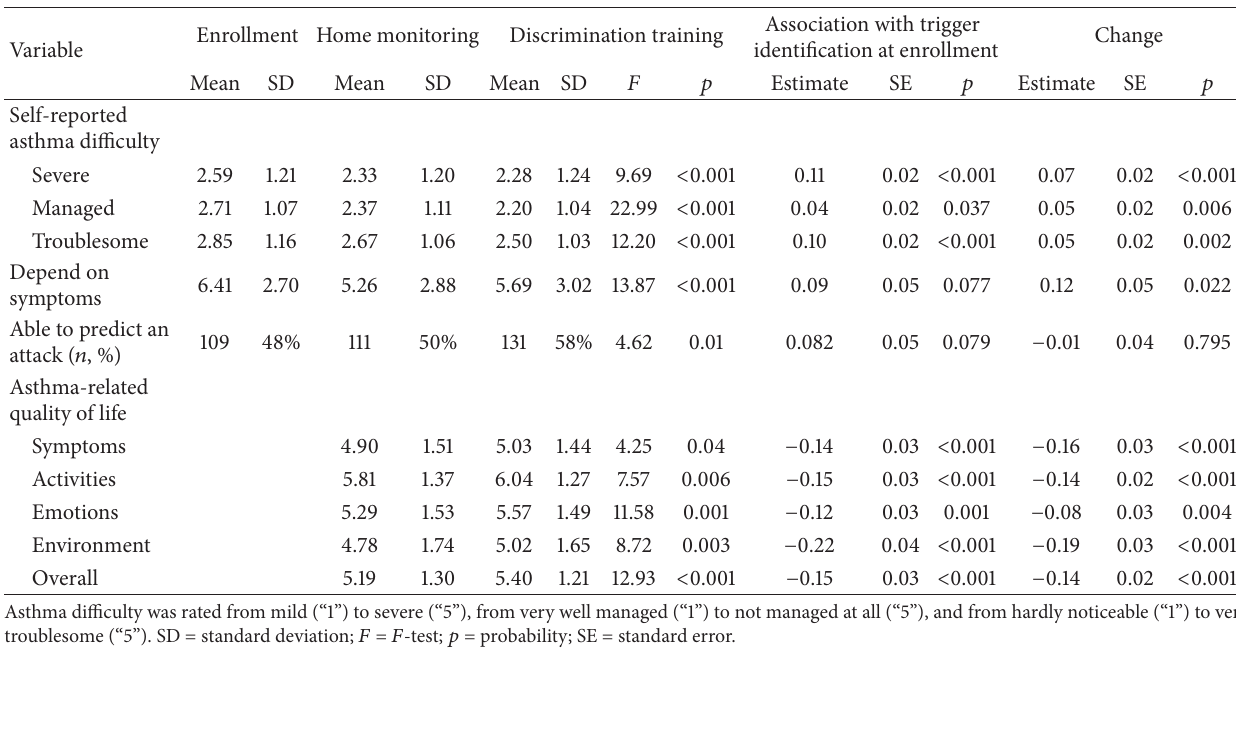
Table 2: Self-reported asthma outcomes and associations with asthma trigger identification.